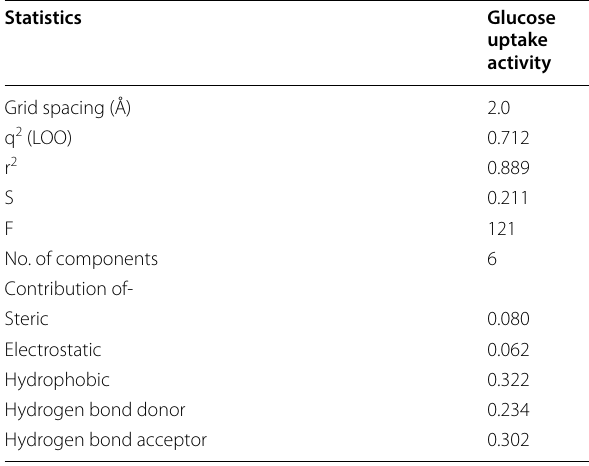
Table 6 Statistical parameters of developed CoMSIA model for glucose uptakeactivity